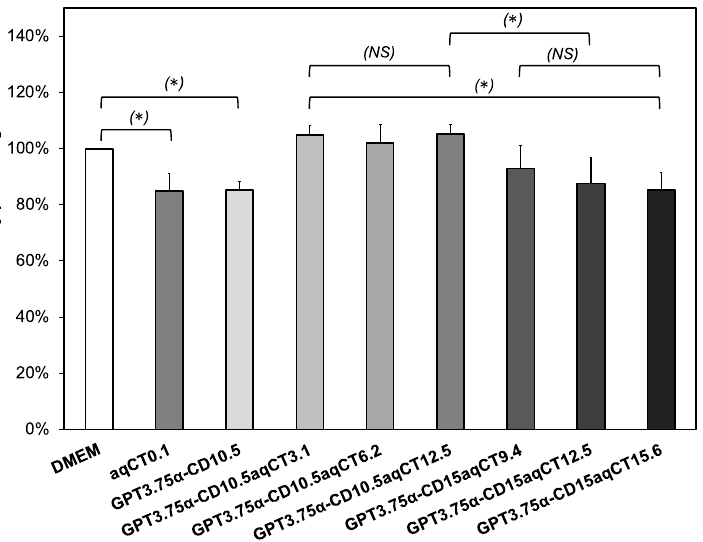
Figure 5. Viability of human dermal fibroblasts (hDFBs) was quantitatively analyzed by WST-1 assay. The hDFBs were incubated with DMEM media (DMEM), the aqCT solution of 0.1 mg/mL, the gel extracts of GPT3.75 α -CD10.5, GPT3.75 α -CD10.5aqCT3.1, GPT3.75 α -CD10.5aqCT6.2, GPT3.75 α - CD10.5aqCT12.5, GPT3.75 α -CD15aqCT9.4, GPT3.75 α -CD15aqCT12.5, and GPT3.75 α -CD15aqCT15.6 for 24 h (* P < 0.05: statistical significance, NS: nonstatistical significance).